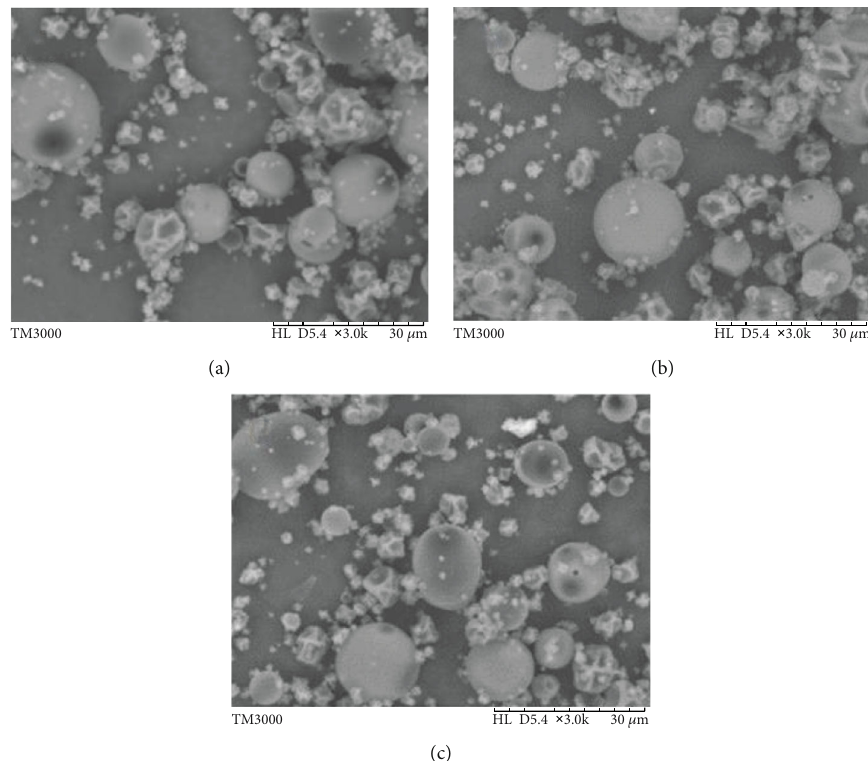
Figure 4: The SEM pictures of SMs (a), DMs (b) and DMs/nano-SiO